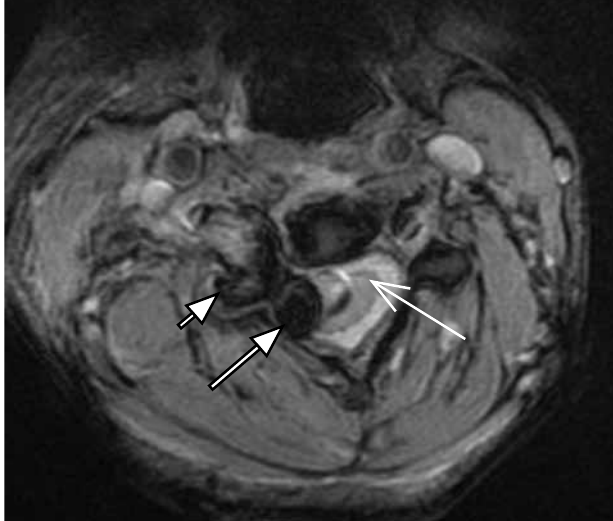
Fig. 2. Axial T2-weighted gradient echo image of the neck demonstrating the large serpiginous signal void (arrow head) of the AVF with an intra-thecal component (filled arrow) causing mass effect on the cervical spinal cord (open